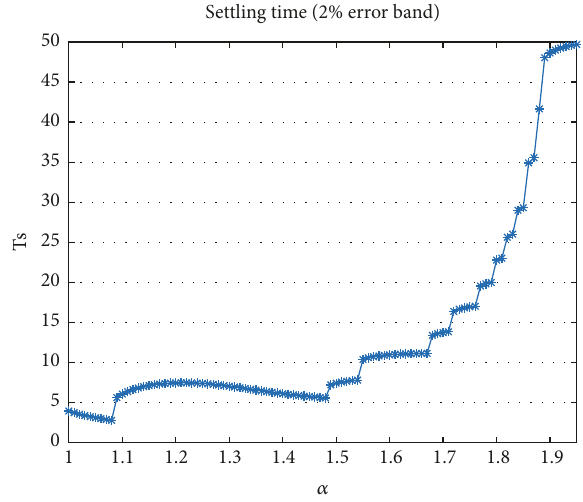
Figure 5: Setting time with different 𝛼 (2%).